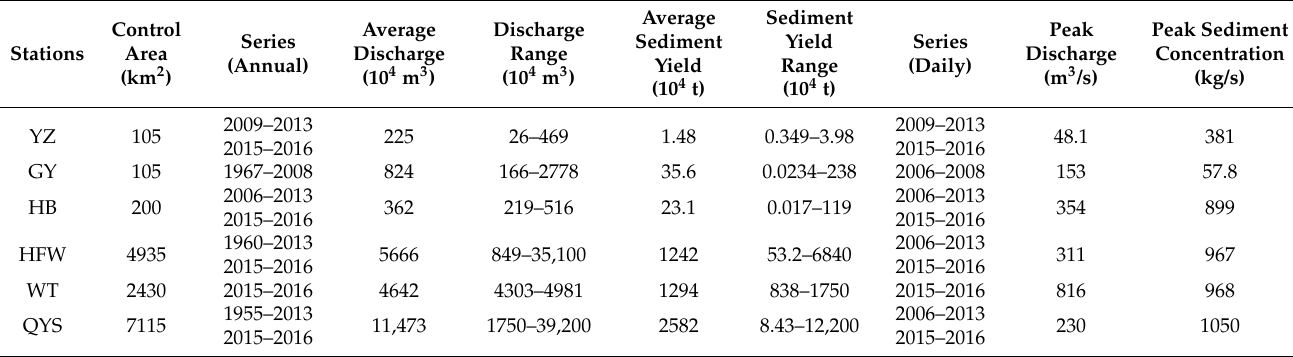
Table 1. Hydrological characteristics of the QRB and data series.